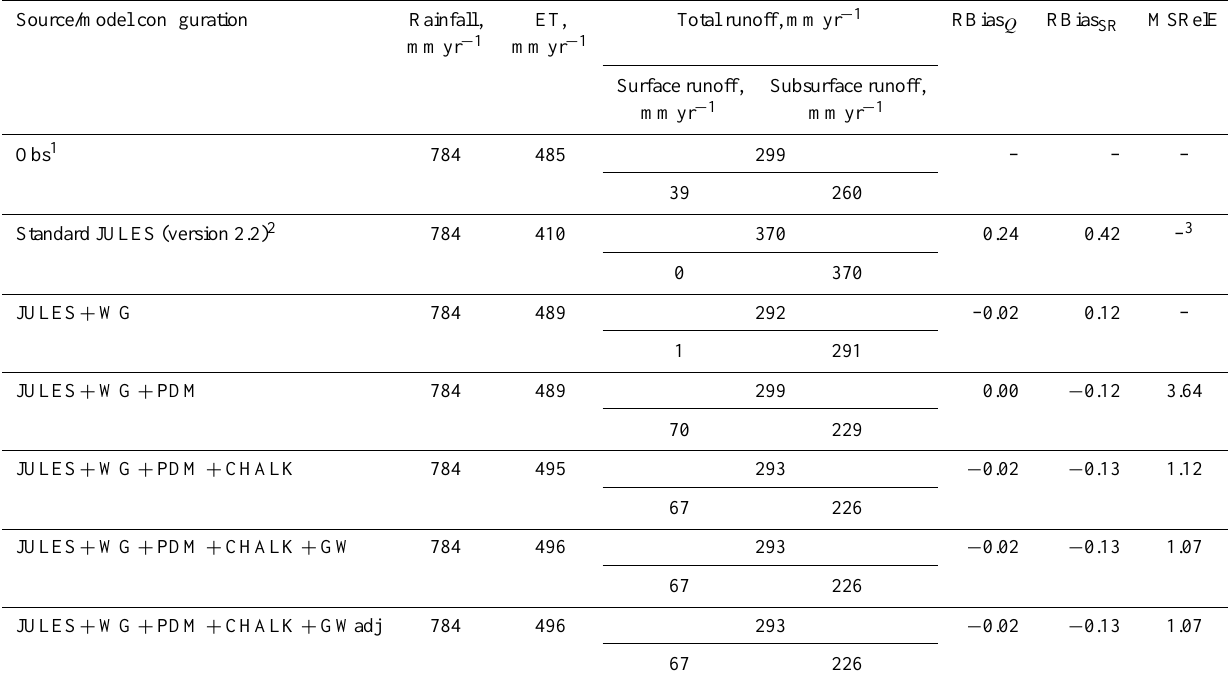
Table 3. Observed and simulated water balance and metrics of model